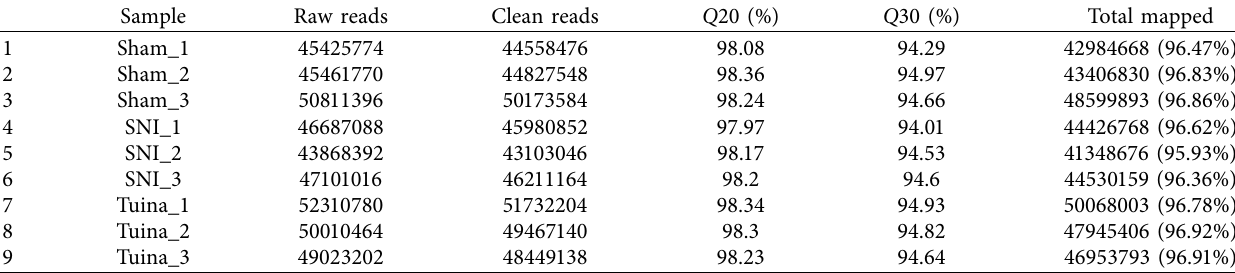
Table 2: Quality control and sequencing information for